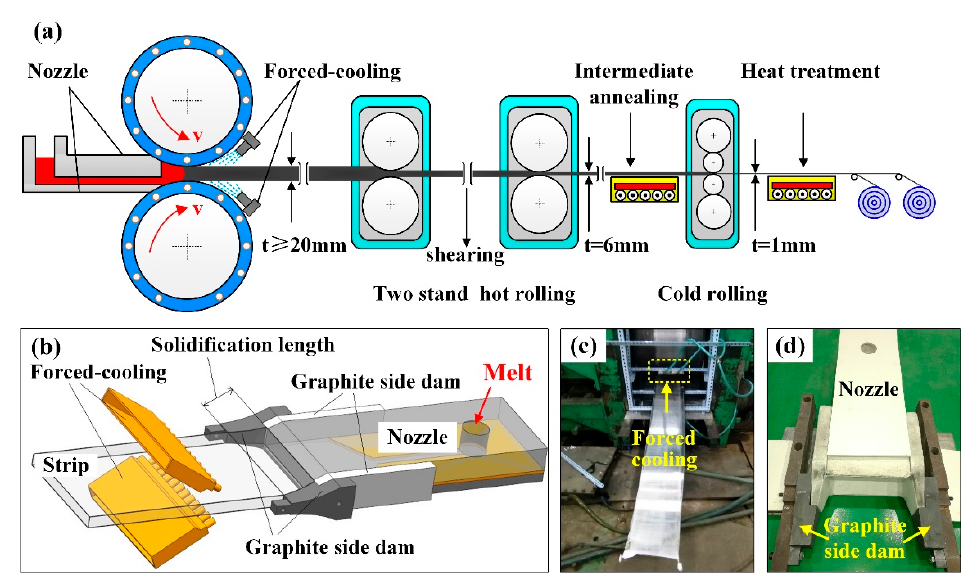
Figure 1. Schematic of twin-roll casting process with forced-cooling (FC-TRC) ( a ). Forced-cooling technology, ( b ) position of forced-cooling device ( c ), and surface quality of twin-roll cast slab ( d ).